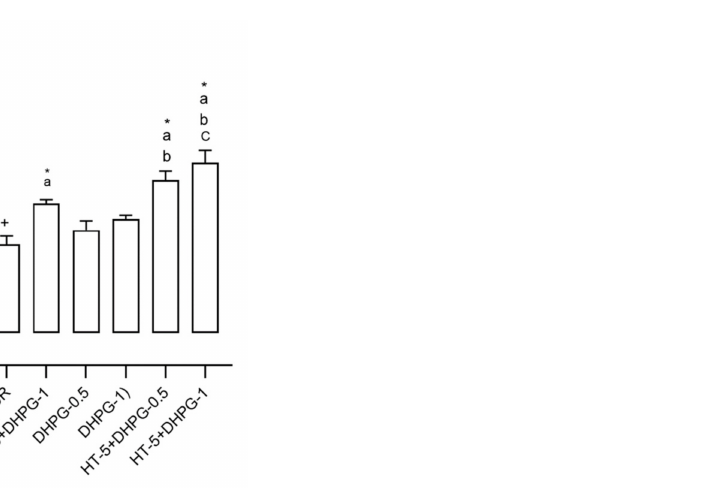
Figure 3. Number of ganglion cells in retinas from healthy rats (NDR); two-month follow-up diabetic rats (DR); and DR treated with hydroxytyrosol 5 mg/kg/day (HT-5), 3,4-dihydroxyphenyglycol 0.5 or 1 mg/kg/day (DHPG-0.5 or DHPG-1), HT-5 plus DHPG-0.5, or DHPG-1, p.o. for two months. n = 10 rats per group. + p < 0.05 with respect to NDR. * p < 0.05 with respect to DR. a p < 0.05 with respect to DHPG-0.5. b p < 0.05 with respect to DHPG-0.5 and DHPG-1. c p < 0.05 with respect to HT-5, DHPG-0.5, and DHPG-1. Table 3. Pearson correlations (Pc) between lactate dehydrogenase efflux (LDH), percentage of retinal surface occupied by cells (%CELL), and biochemical parameters in brain slices subjected to the hypoxia–reoxygenation